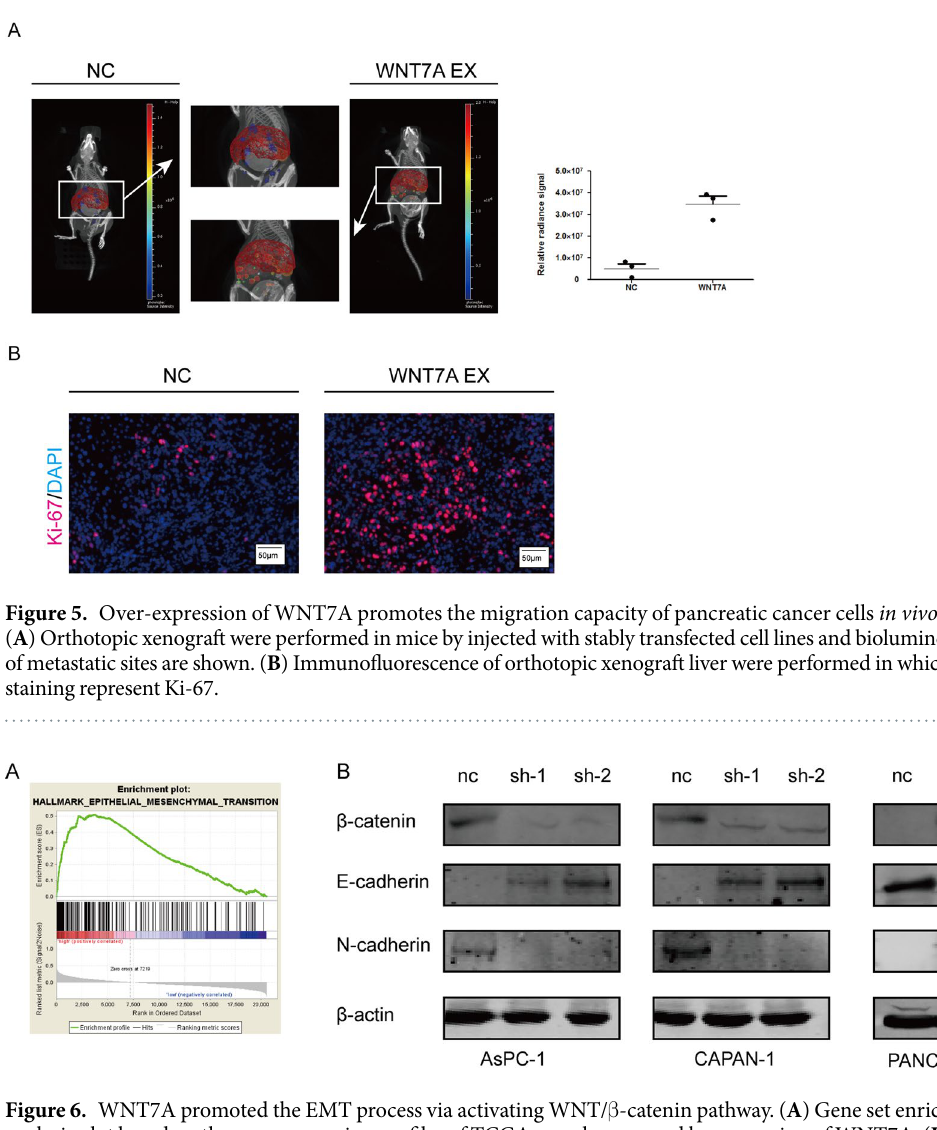
Figure 6. WNT7A promoted the EMT process via activating WNT/ β -catenin pathway. ( A ) Gene set enrichment analysis plot based on the gene expression profiles of TCGA samples grouped by expression of WNT7A. ( B ) The expression of β -catenin, E-cadherin and N-cadherin in PDAC cell lines with WNT7A down-regulated and over- expressed are detected by Western blot. The relative expression was normalized to β -actin in cell